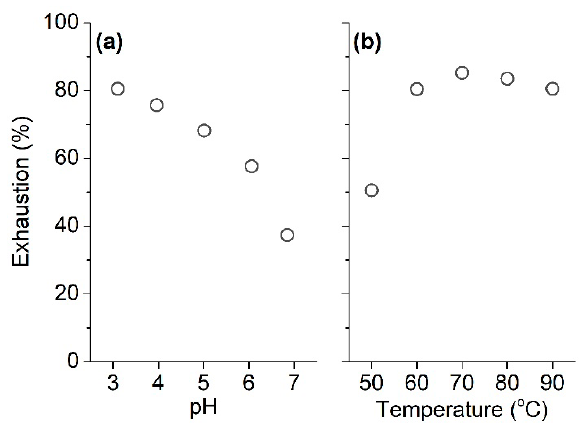
ff ect of pH ( a ) and temperature ( b ) on the adsorption of tannic acid on Figure 2. Effect of pH ( a ) and temperature ( b ) on the adsorption of tannic acid on silk. Figure 2. E